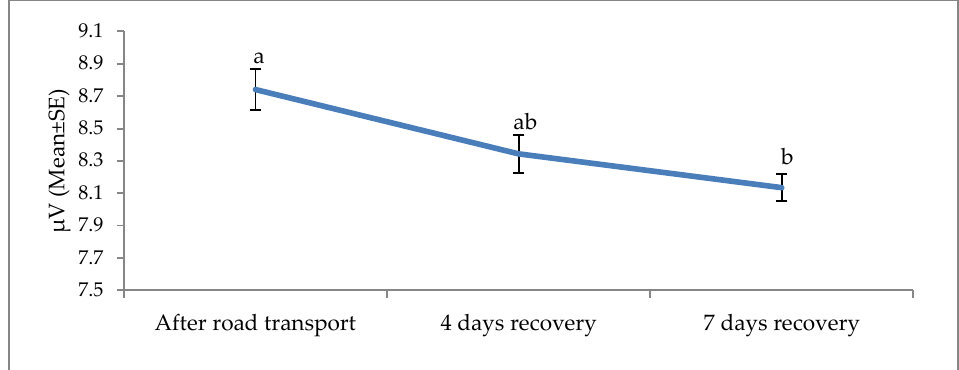
Figure 7. Effects of road transport on the theta root mean square (RMS) in cattle. The number of animals used in each sampling point was 24 heifers. Means with different letters are significantly different at p < 0.05.